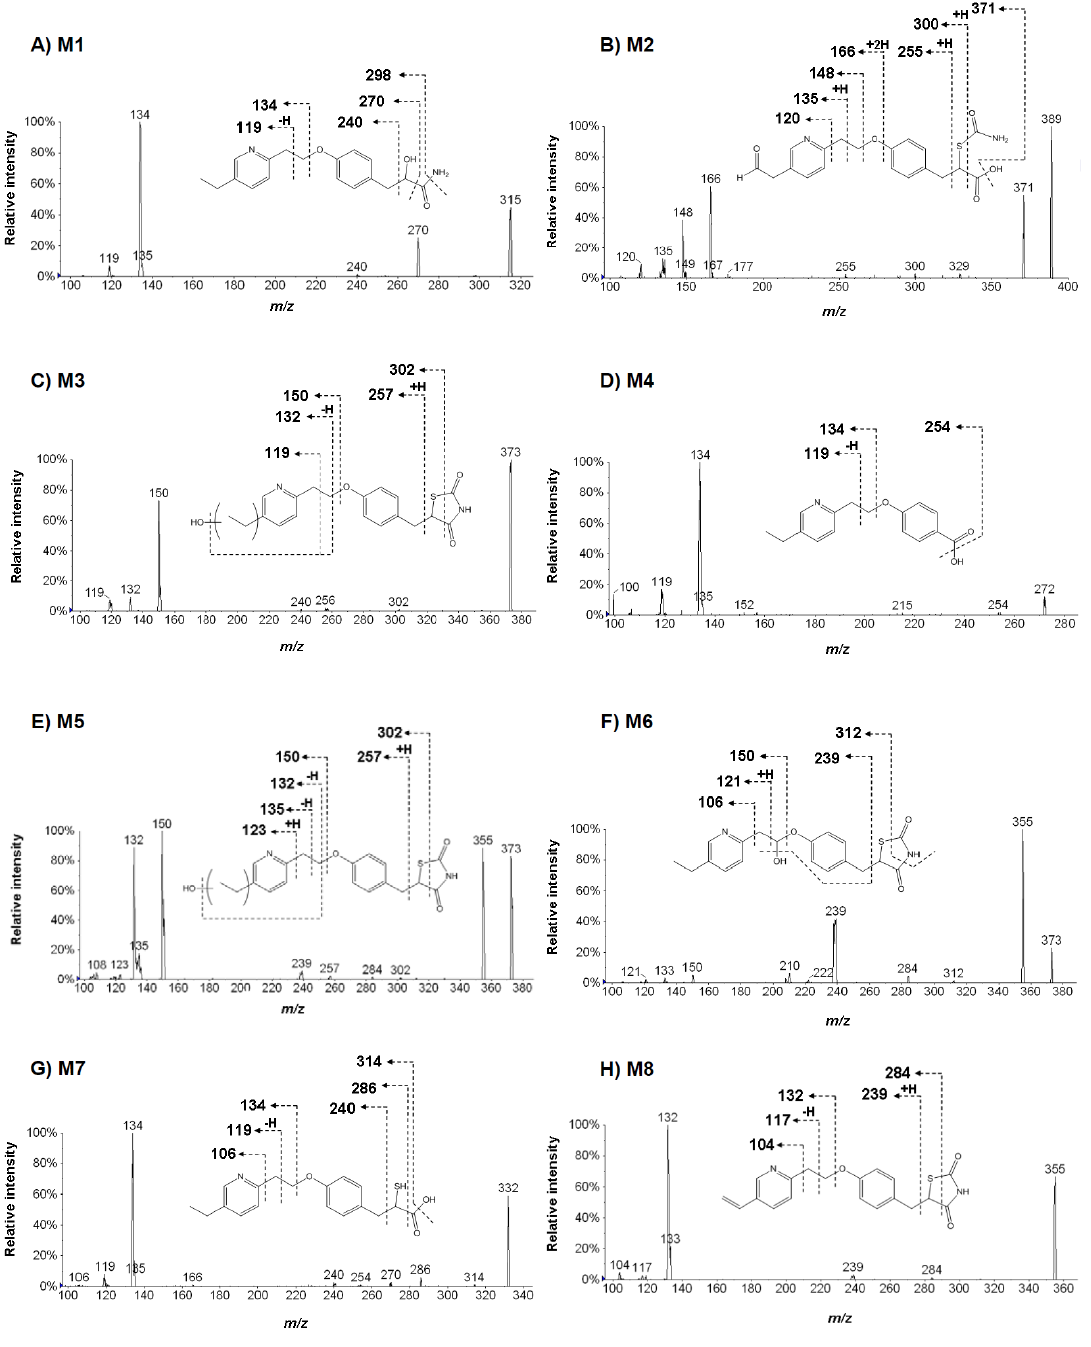
Figure 6. Representative MS/MS spectra of eight pioglitazone metabolites and their estimated chemical structures. Precursor ions were m/z 315 ( A ), 389 ( B ), 373 ( C ), 272 ( D ), 373 ( E ), 373 ( F ), 332 ( G ) and 355 ( H ) with the positive ion mode. Each arrow indicates a possible site of fragmentation, with the corresponding